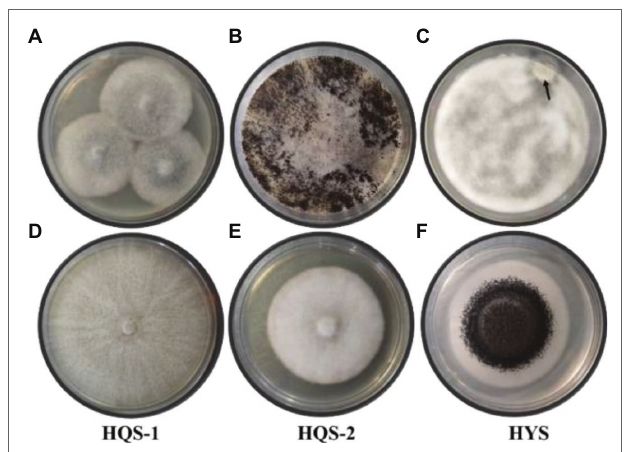
FIGURE 1 | Colonies of preliminarily isolated fungal from chalkbrood samples and colonies of purified fungi. Chalkbrood mummies treated with method 1 and cultured on PDA plate for 6 days (A) . Chalkbrood mummies treated with method 1 and cultured on PDA plate for 30 days (B) . Chalkbrood mummies treated with method 2 and cultured on PDA plate for 2 days (C) . Colonies growing from the hyphal tip isolated from the colony of (A) (D,E) . Colony growing from the single spore isolated from the colony of (B) (F)